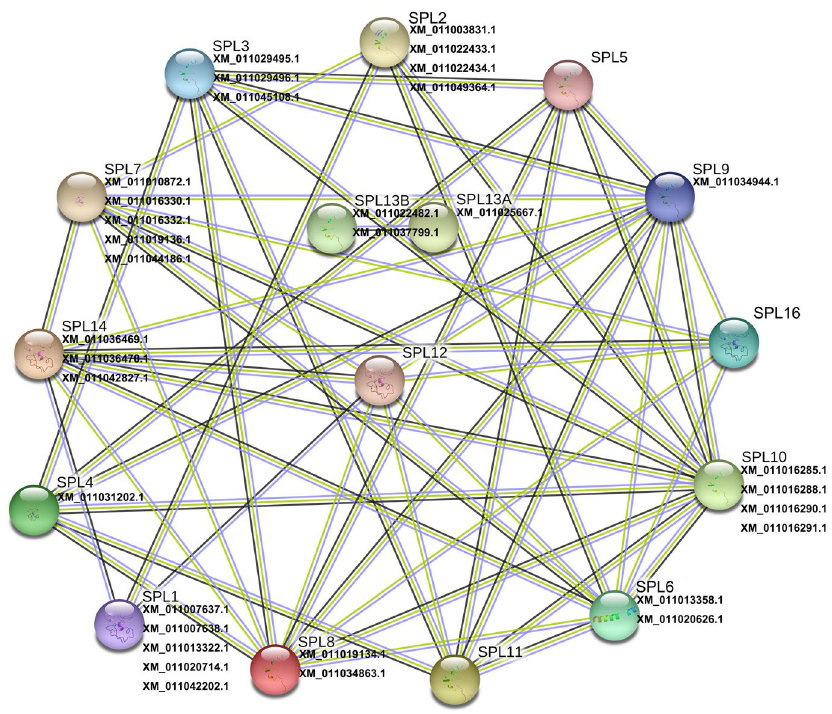
Figure 5. Functional interaction networks of SPL proteins in P. hl based on Arabidopsis orthologs . Nodes represent proteins, filled nodes shows the proteins with known or predicted 3D structure, empty nodes present the proteins whose 3D structure is unknown. Edges represent protein–protein association, black edges represent co-expression interactions, yellow edges represent textmining interaction, blue edges represent protein homology. This figure was generated by STRING (https:// string- db.